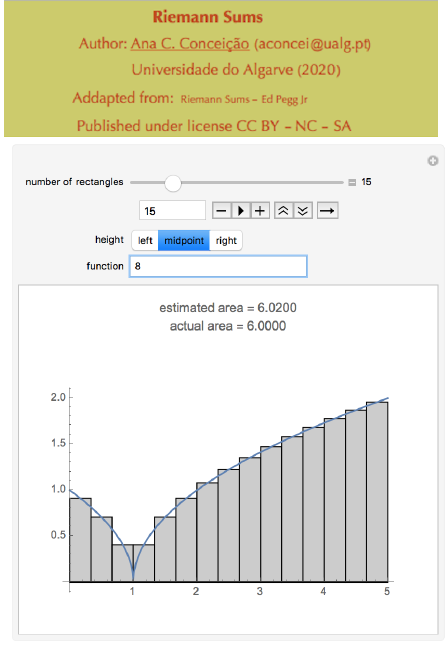
Figure 6. Image with four dynamic and interactive tools to compute integrals of rational functions.